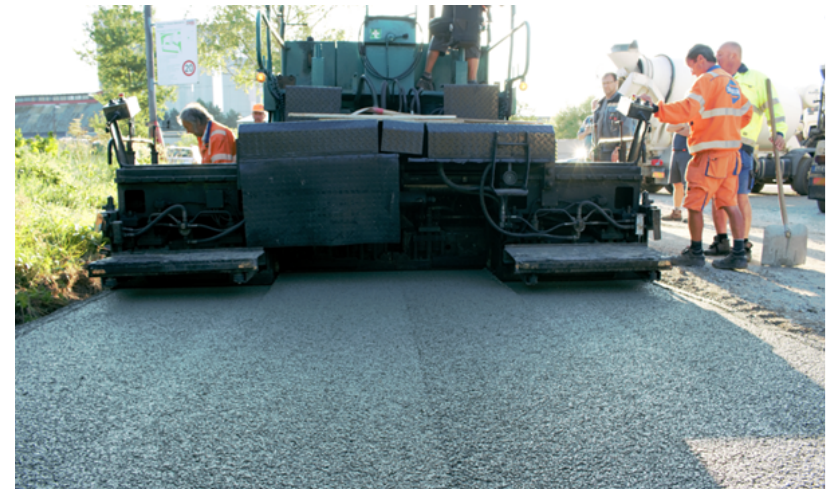
Figure 3. Laying down of pervious concrete.